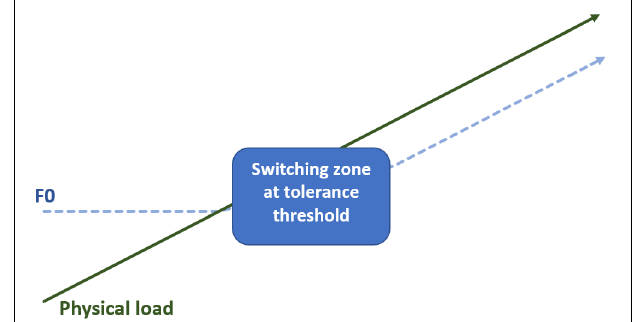
FIGURE 1 | Switching zone of voice reactivity to physical load. As a consequence of a competition for ventilation processes, F0 increases in response to physical load from the point that this load is not well tolerated anymore (e.g., Johannes et al.,